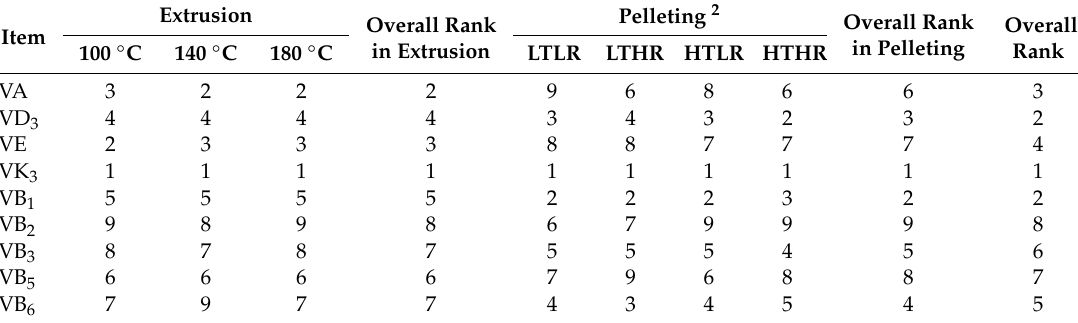
Table 8. Comparison and ranking of activity loss of microencapsulated vitamins in extrusion and pelleting 1